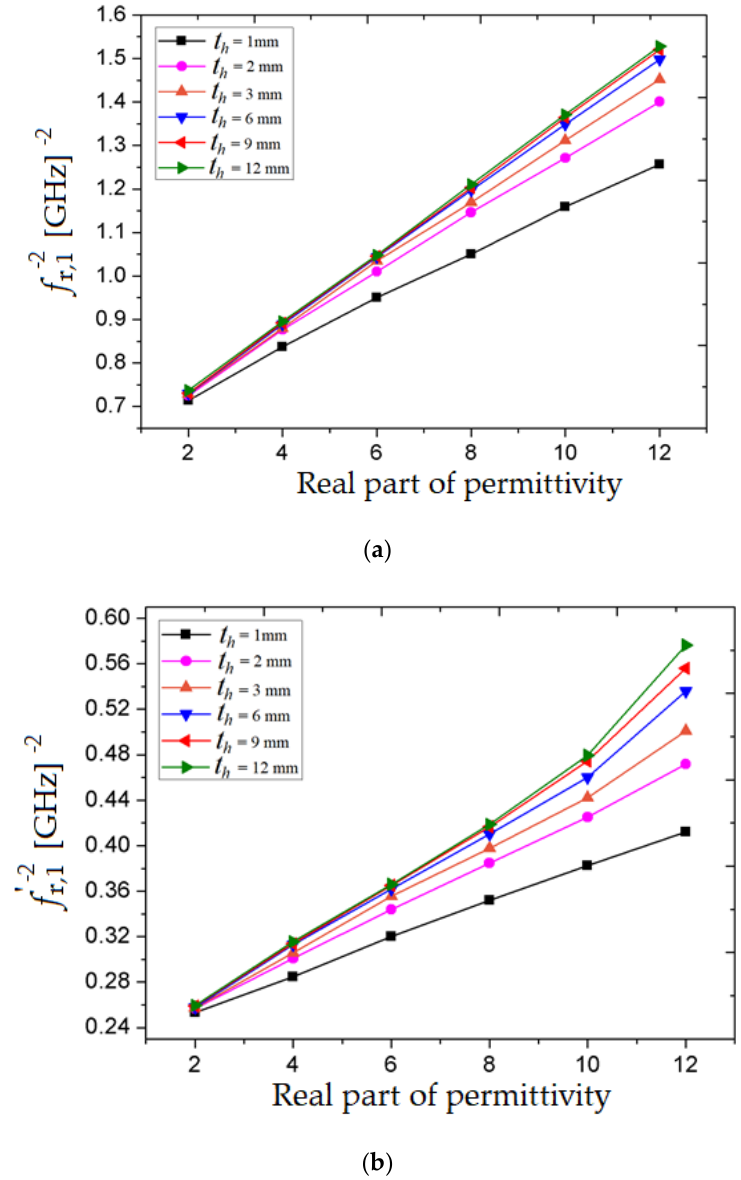
Figure 7. Resonant frequencies in terms of real permittivity ( ε ʹ r ) for different thickness of MUT: ( a ) First resonant frequency ( f r,1 ) − 2 ; ( b ) second resonant frequency ( f ʹ r,1 ) − 2.